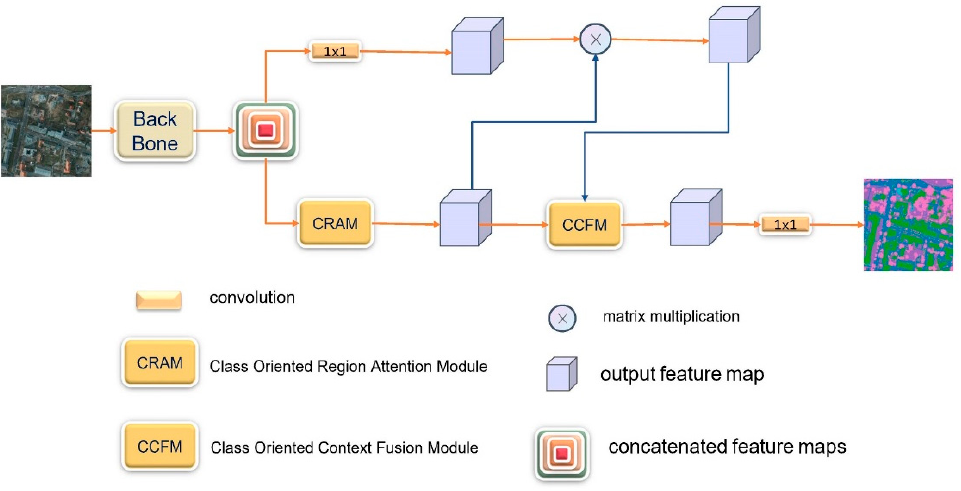
Figure 2. The pipeline of our method.